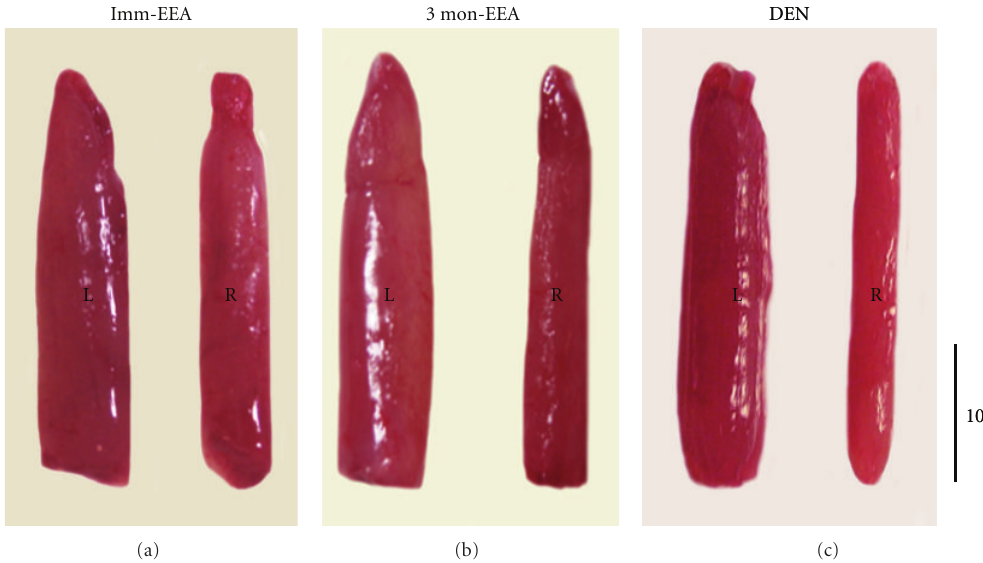
Figure 9: Photographs of the removed SM muscles showing the extent of muscle atrophy in three experimental groups. (a) A pair of SM muscles from a rat in the immediate EEA (Imm-EEA) group. (b) A pair of SM muscles from a rat in the 3-month delay EEA (3 mon-EEA) group. (c) A pair of SM muscles from a rat with denervation (DEN) of the right SM caused by nerve transection. In each rat, the left (L) SM was normal, whereas the right (R) SM was reinnervated or denervated.